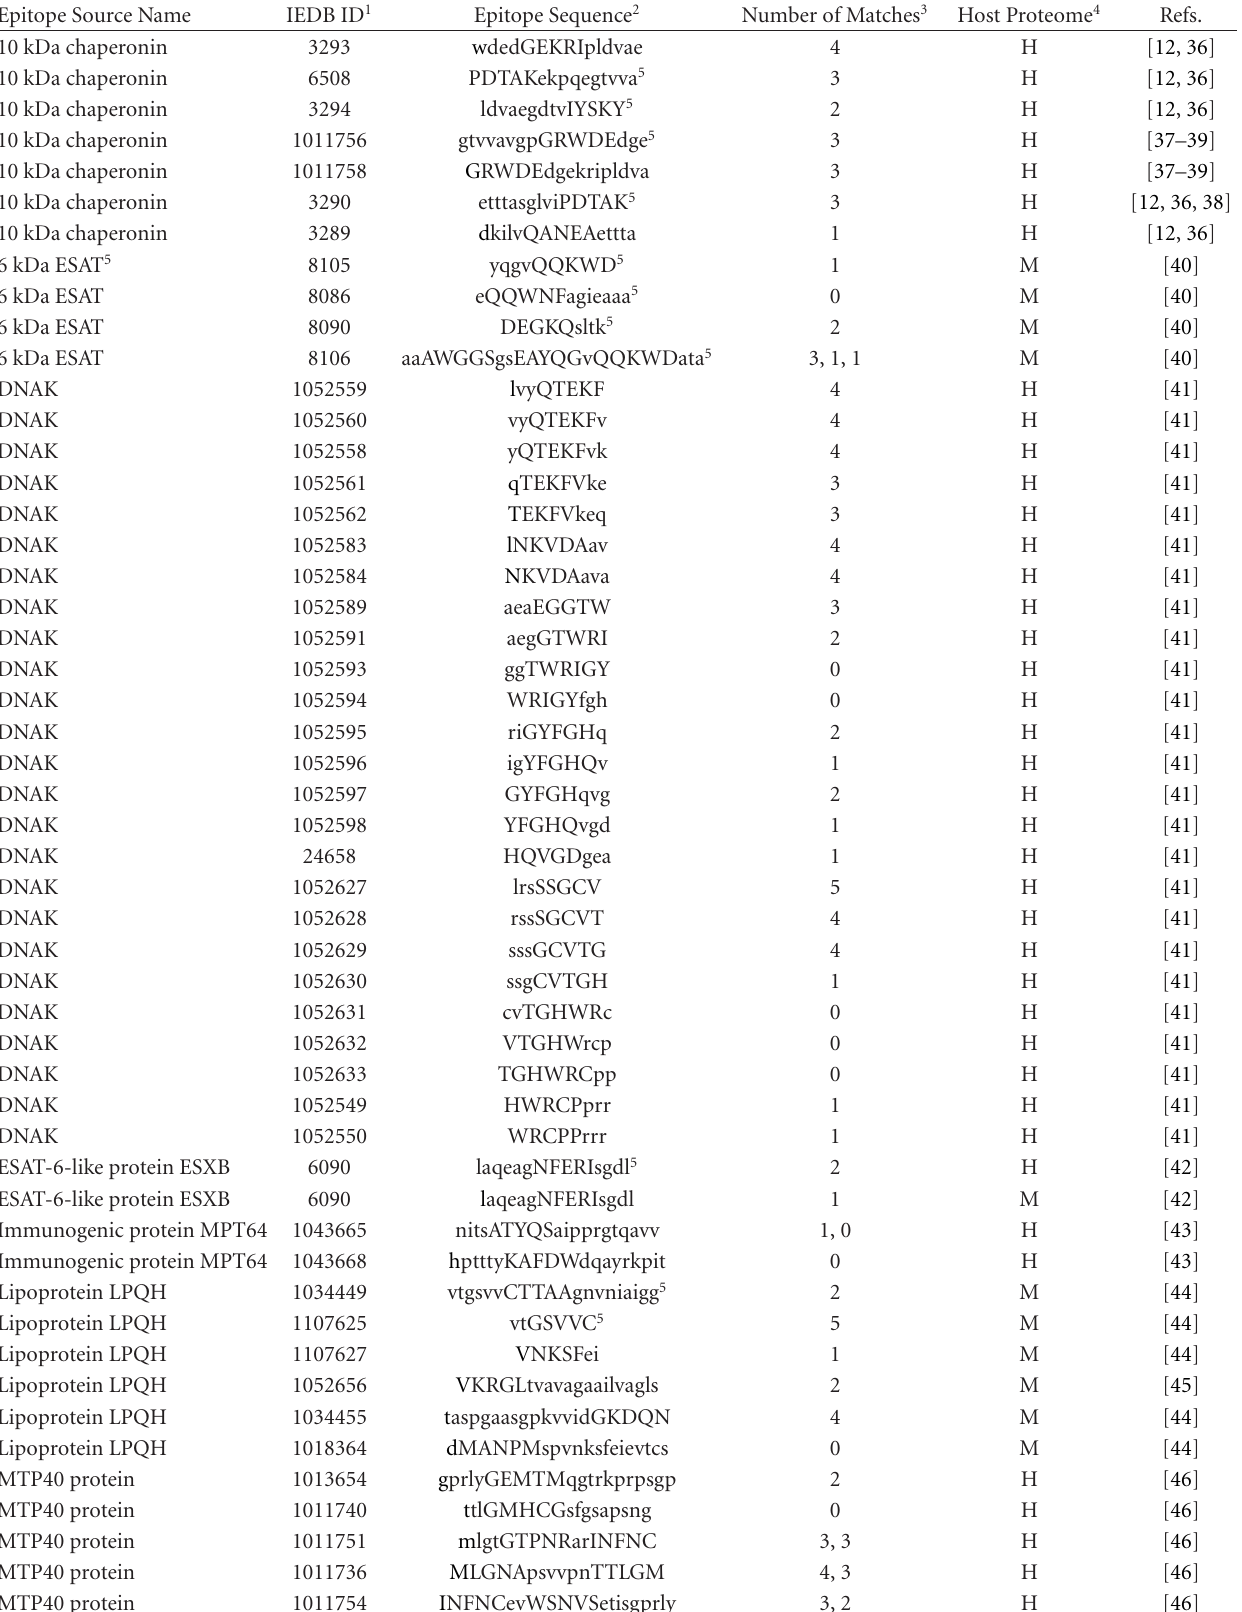
Table 1: Similarity analysis of M. tuberculosis B-cell epitopes to the host